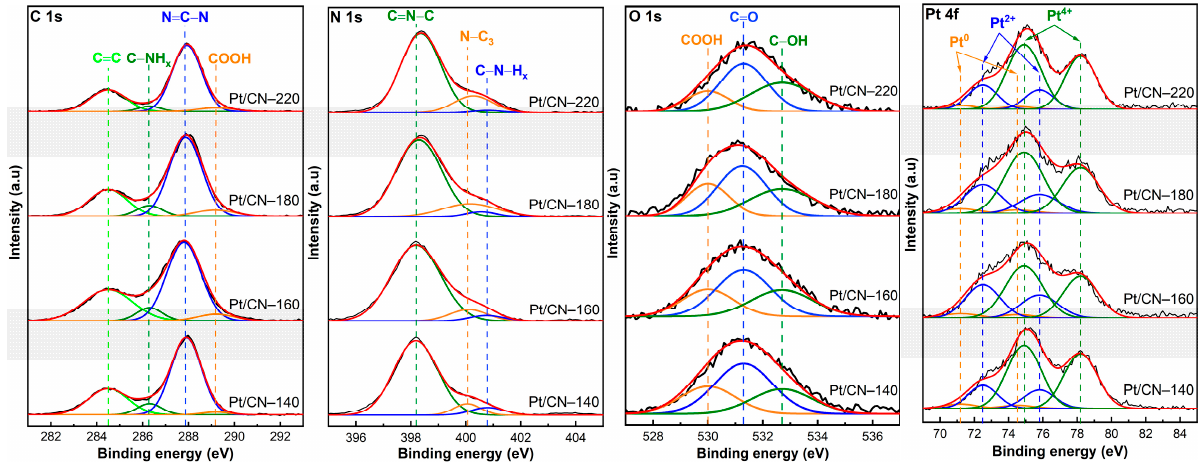
Figure 5. The XPS spectra of C 1s, N 1s, O 1s, and Pt 4f of the Pt/CN photocatalysts. Table 2. Elemental analysis and C, N, and Pt phases of the Pt/CN photocatalysts.